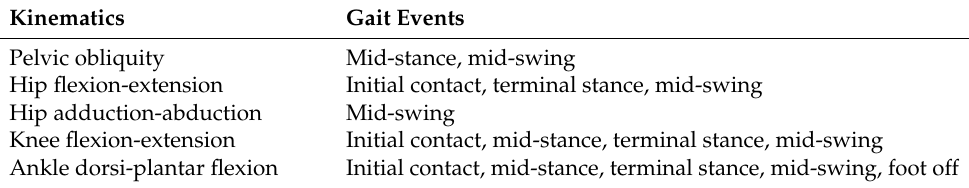
Table 2. Maximal joint kinematic values analyzed at defined gait